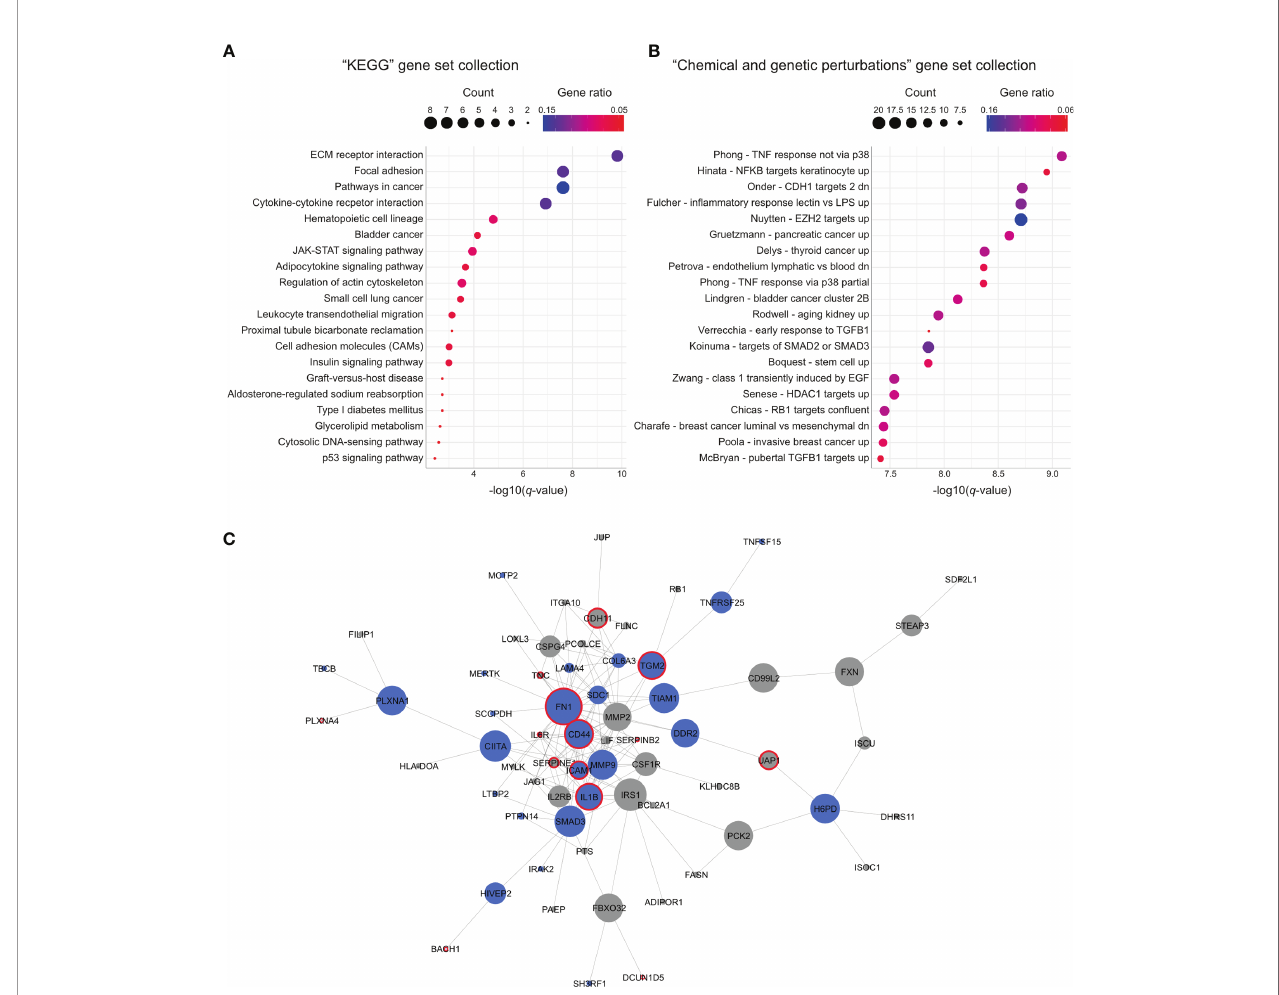
FIGURE 4 | Gene sets and network regulated by both FUS-DDIT3 expression and ruxolitinib treatment. (A) Signi fi cantly enriched gene sets from the “ KEGG ” gene set collection using the 126 commonly regulated genes. Top 20 gene sets based on q -value are shown. Gene count is indicated by dot size and gene ratio by color. (B) Signi fi cantly enriched gene sets from the “ chemical and genetic perturbations ” gene set collection using the 126 commonly regulated genes. Top 20 gene sets based on q -value are shown. Gene count is indicated by dot size and gene ratio by color. (C) Interaction network created with Cytoscape (29) based on protein interaction data retrieved from STRING (30). Node size is based on betweenness centrality. Nodes marked in blue indicate common STAT3-bound genes and red borders indicate proteins that match to the “ Nuytten - EZH2 targets up ” gene set from the “ chemical and genetic perturbations ” gene set